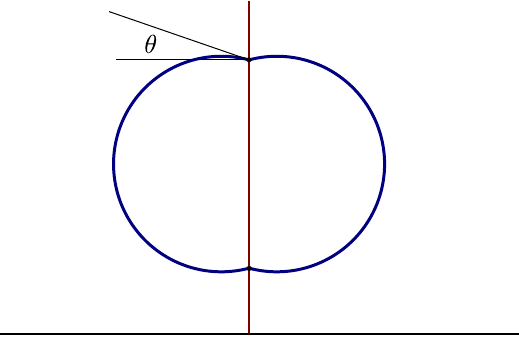
Figure 7 . The near-AdS boundary for the symmetric